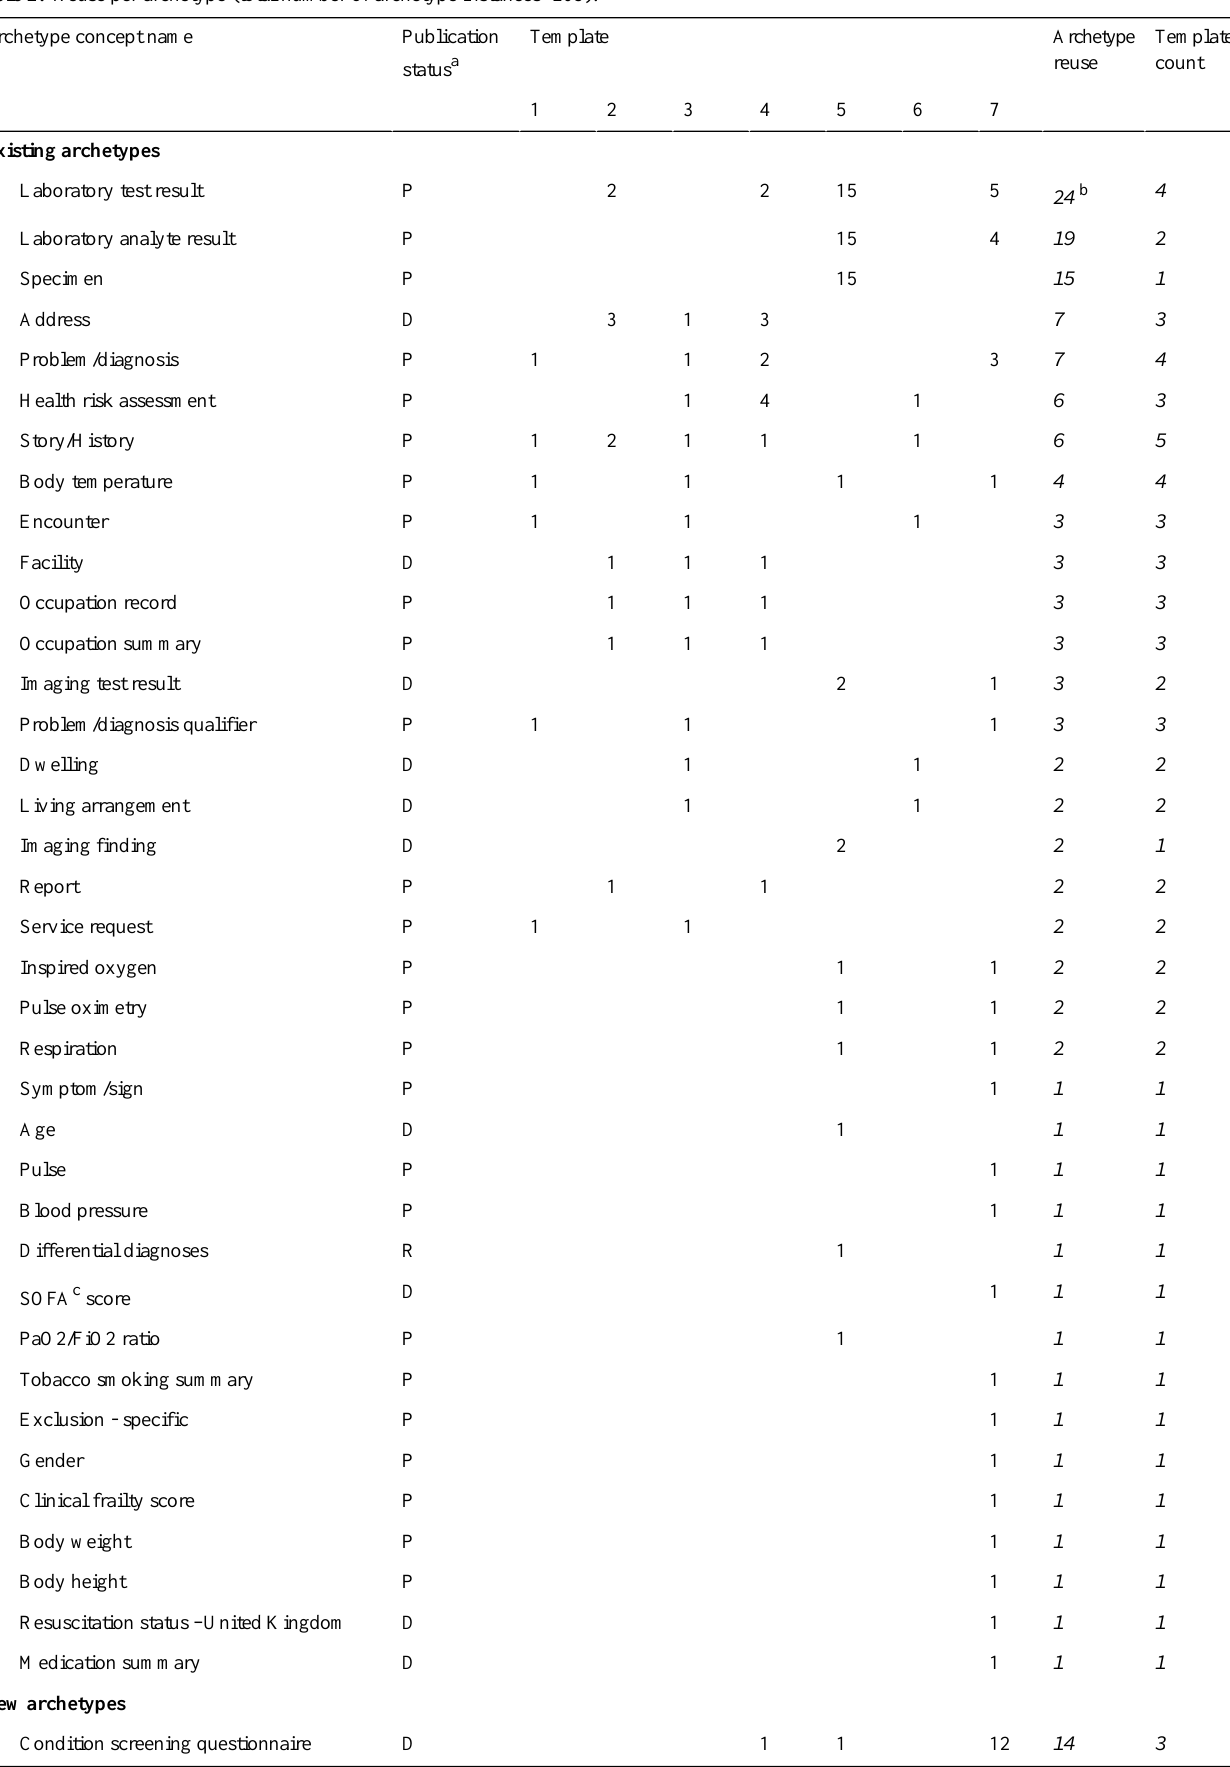
Table 2. Reuse per archetype (total number of archetype